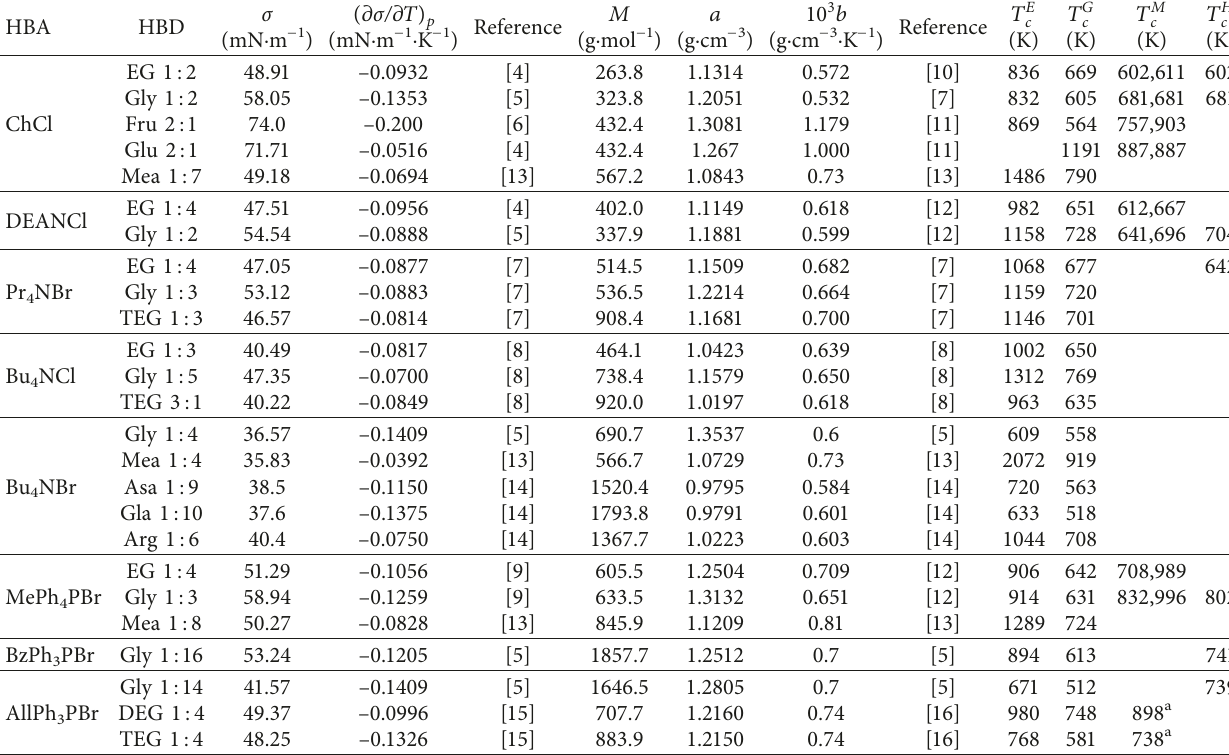
Table 1: The surface tension σ at 298.15K and its temperature coefficient ( z σ / z T ) ρ � a − b ( t / ° C ) of deep eutectic solvents; and the derived critical temperatures: T E c according to (3), T G c according to (4), T M c from Mirza et al. [1], and T H c from Haghbakhsh et al.